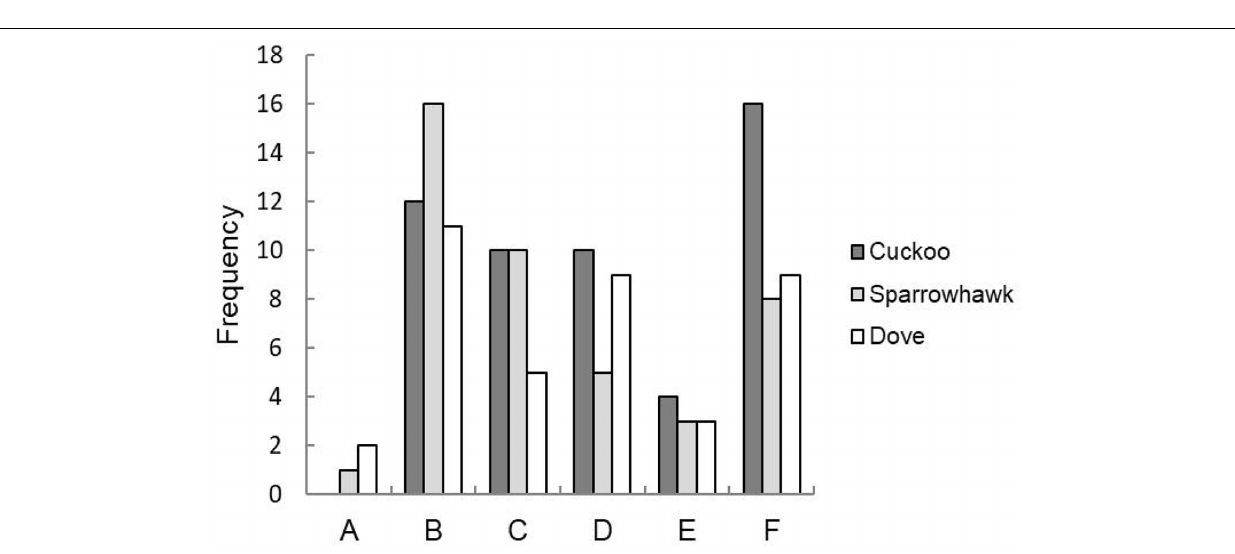
Frontiers in Ecology and Evolution |